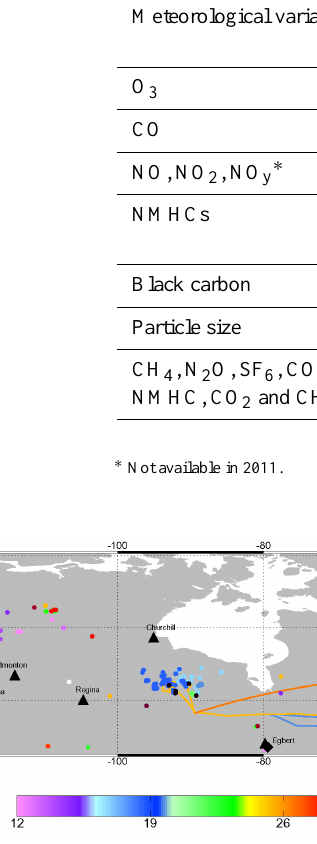
Fig. 6. Flight tracks for BORTAS, excluding inbound/outbound transit flights. Solid upward triangles denote ozonesonde launch sites, and the solid square denotes the Dalhousie ground station. The colour circles denote active burning throughout the BORTAS period. The flights and burning areas use a common colour scale that denotes the day number starting on 12 July